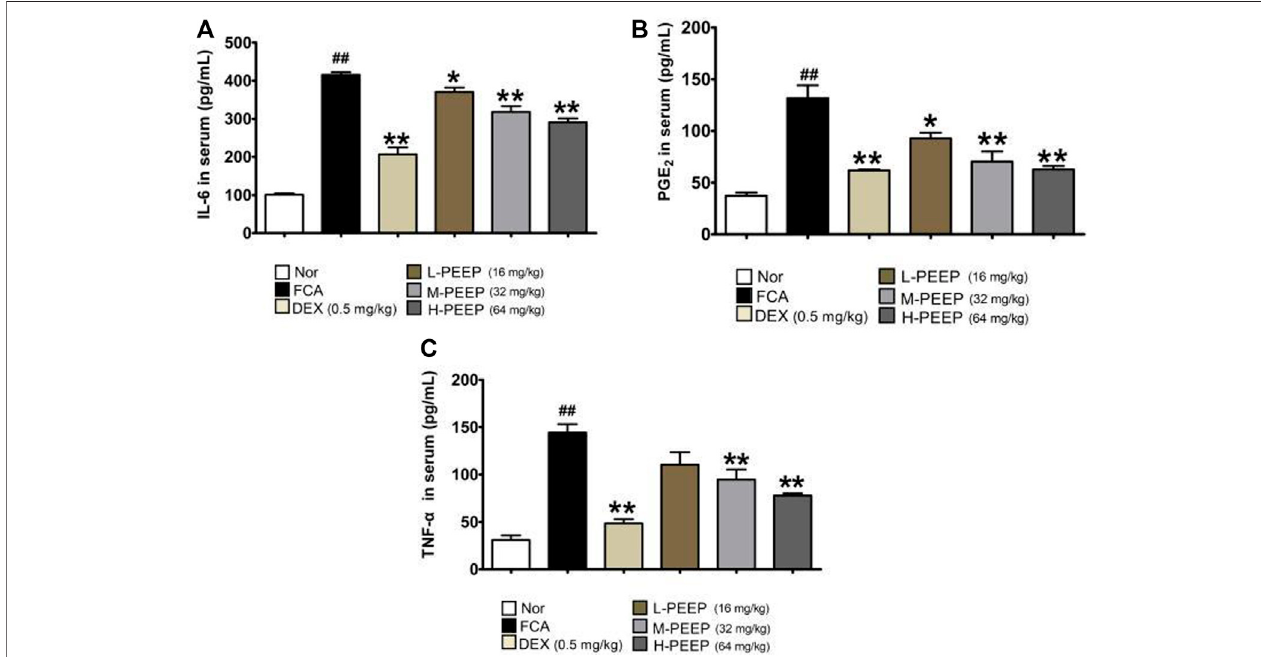
FIGURE 6 | Effects of different doses of PEEP on the expression of in fl ammatory cytokines in CFA rat serum. (A) The concentrations of IL-6 in serum were determined by ELISA. (B) The concentrations of PGE2 in serum were determined by ELISA. (C) The concentrations of TNF- α in serum were determined by ELISA. The data were expressed as the means ± S.E.M. ( n = 5). ## p < 0.05 vs. Normal group; * p < 0.05, ** p < 0.01 vs. CFA